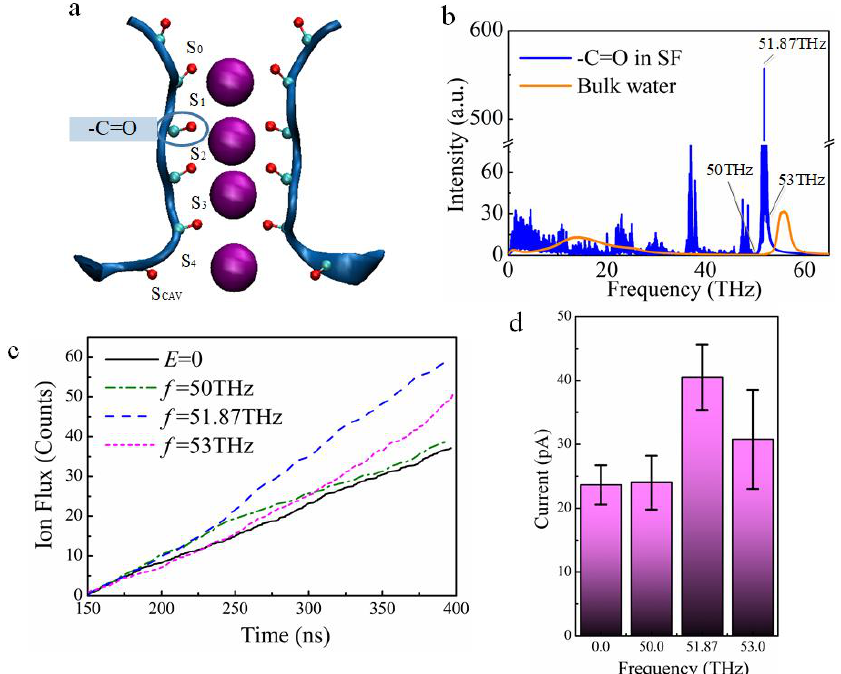
Figure 2. THz electric field increases the ion flux. ( a ) The oxygen atoms in -C=O groups of the SF region are tightly bound to K + (purple spheres are potassium ions). ( b ) Comparison between the absorption of the -C=O groups in SF (blue curve) and that of the bulk water (orange curve). ( c ) Changes of ion flux caused by THz electric field with different frequencies. ( d ) The effect of different frequencies on the current.